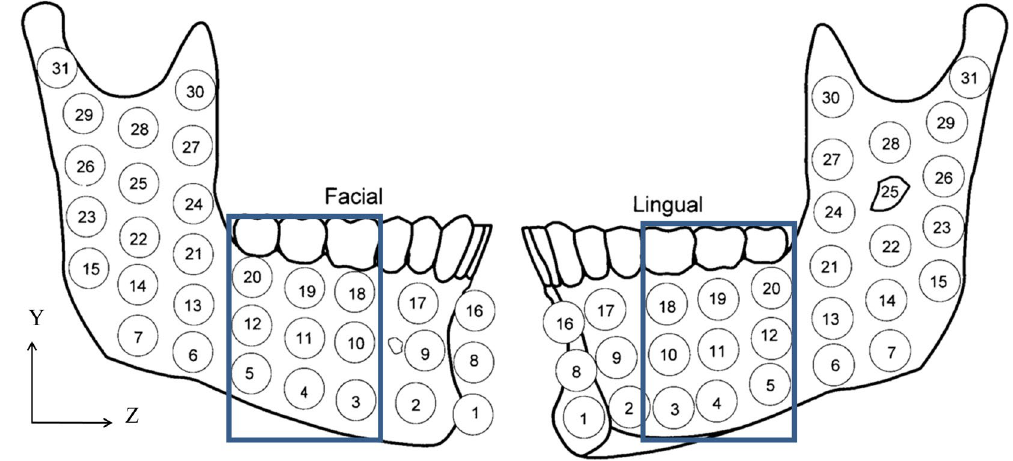
Figure 6. Mandible containing samples (9 × 2) of interest for mechanical properties 17 , the blue rectangle indicates the bone section used in the model. Reprinted with permission from ref.